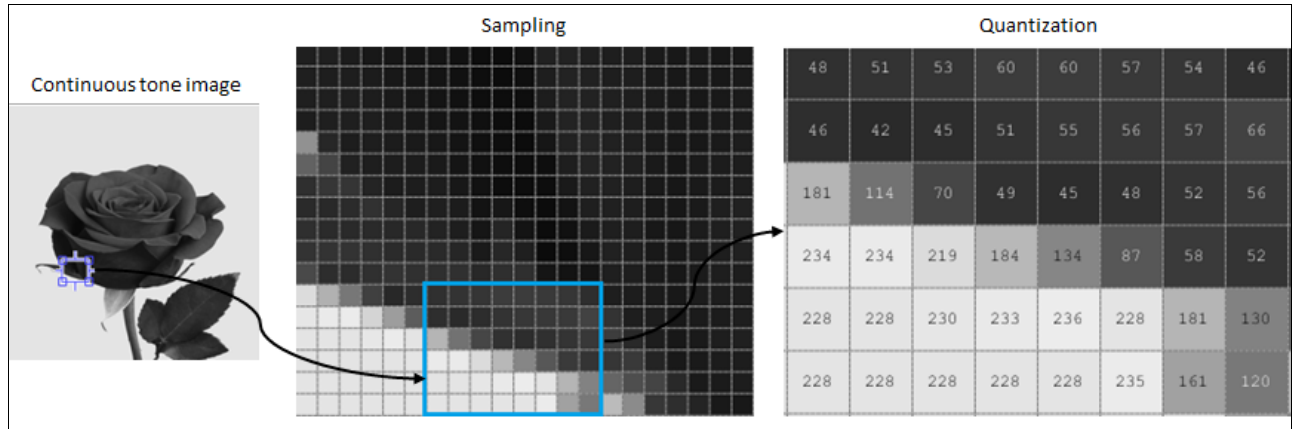
Figure 1. Steps used to convert a continuous tone image to a digital one. The bit depth indicates the number of bits used to represent a pixel, where a higher bit depth represents more colours, thus increasing the file size of an image [19]. A greyscale image is a matrix of A × B pixels, and 8-bit and 16-bit greyscale images contain 2 8 = 256 and 2 16 = 65,536 different colours, respectively, where the ranges of colour values are from 0–255 and 0–65,535. Figures 2 and 3 show examples of 8-bit and 16-bit greyscale images,